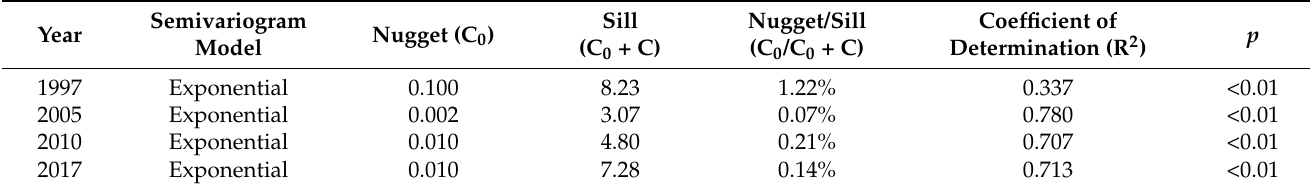
Table 1. Semi-variance function analysis parameters of carbon emission intensity in the Yangtze River Delta from 1997 to 2017.